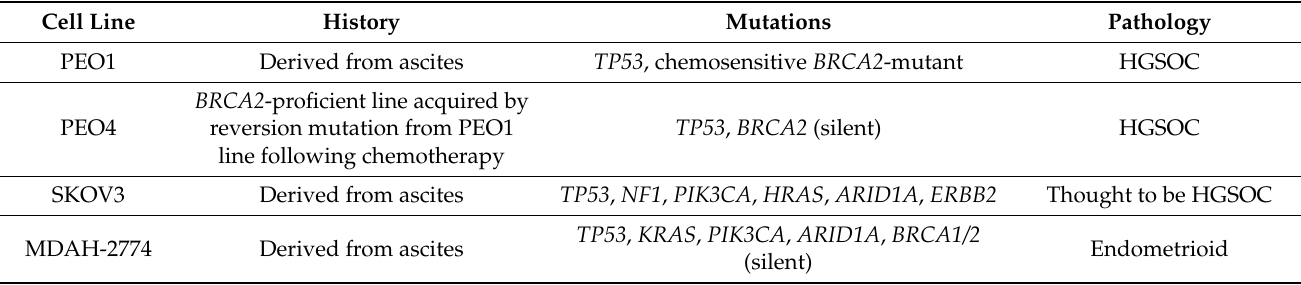
Table 1. List of all cell lines used in this study. TP53: tumor protein 53, NF1: Neurofibromin 1, PIK3CA: Phosphatidylinositol- 4,5-Bisphosphate 3-Kinase Catalytic Subunit Alpha, HRAS: HRas Proto-Oncogene, GTPase, ARID1A: AT-Rich Interaction Domain 1A, ERBB2: Erb-B2 Receptor Tyrosine Kinase 2, and KRAS: KRAS Proto-Oncogene,